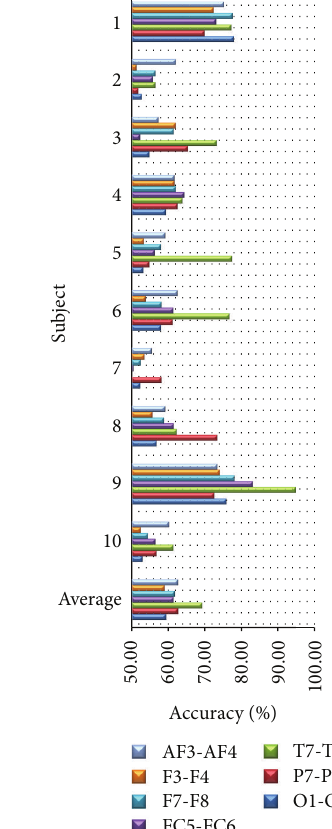
Figure 7: Accuracy from each pair of channels.